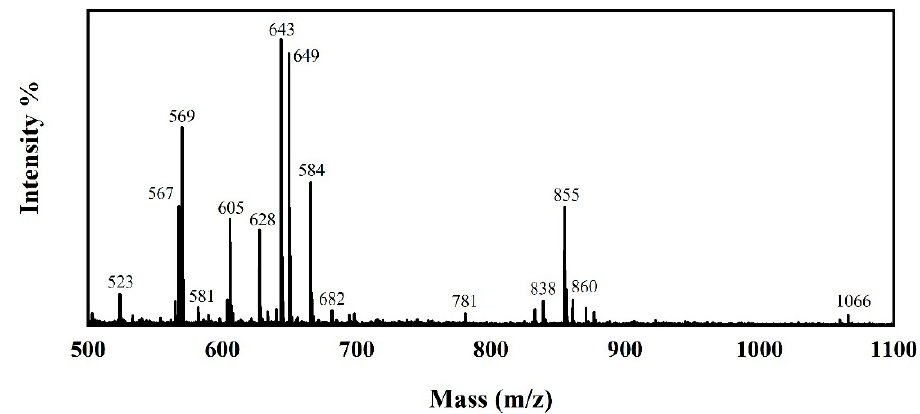
Figure 17. The MS spectra of the friction-tested aluminum plates lubricated using the 2% JD2000 aqueous solution.